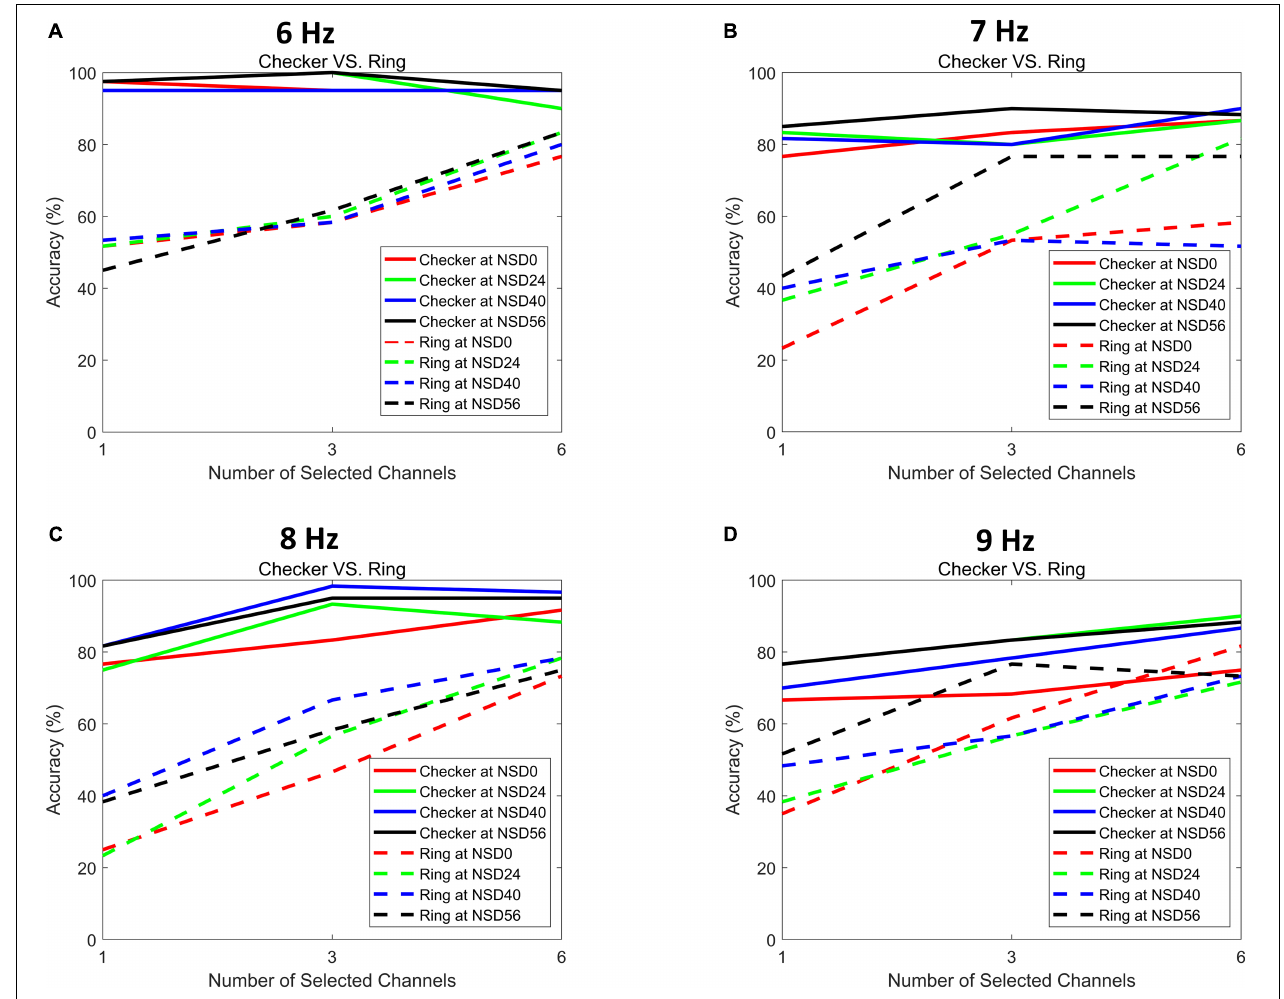
FIGURE 6 | Performance comparisons for different channel selections. (A) Averaged detection accuracies of different channel selections at an MRF of 6 Hz. (B) Averaged detection accuracies of different channel selections at an MRF of 7 Hz. (C) Averaged detection accuracies of different channel selections at an MRF of 8 Hz. (D) Averaged detection accuracies of different channel selections at an MRF of 9